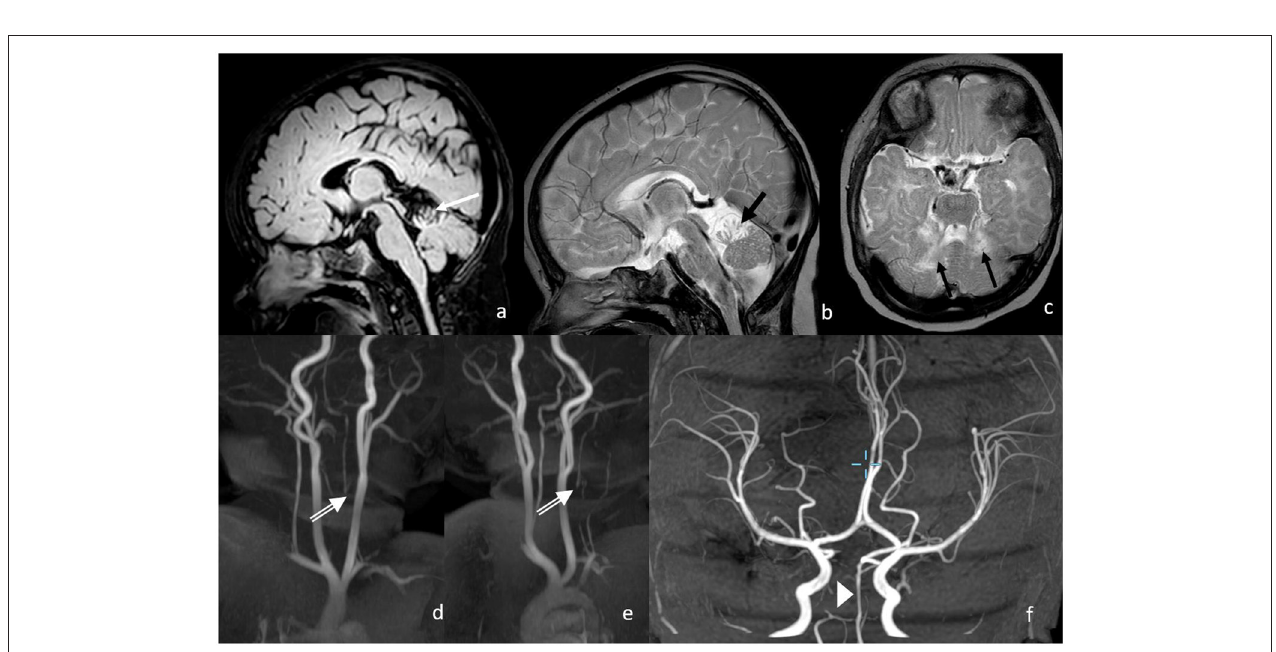
FIGURE 4 | Three months following up of MRI and MRA. Postischemic defects in bilateral SCA territory with focal atrophy in the cerebellum on the following: (a) FLAIR (white arrow); (b,c) T2w (black arrows), proximal vertebral artery shows no antegrade flow in v0-V2 with distal reperfusion; (d,e) white double arrows; and (f) the basilar artery shows normal flow